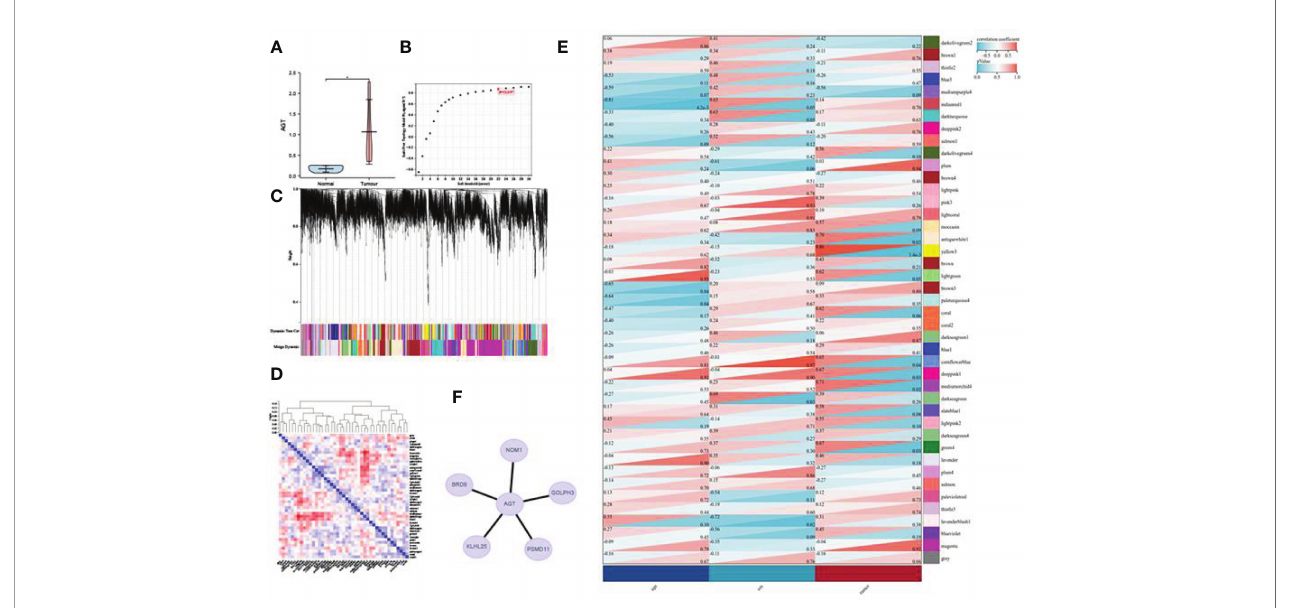
FIGURE 8 | WGCNA analysis: (A) Expression of AGT in gastric cancer based on the sequencing expression matrix; (B) soft threshold; (C) gene clustering; (D) module eigenvector clustering; (E) module and phenotype correlation heat map; (F) AGT coexpression network. *p <